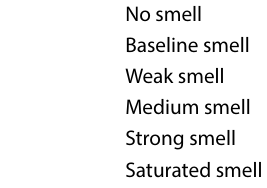
Table 1 Relative odour intensity scale